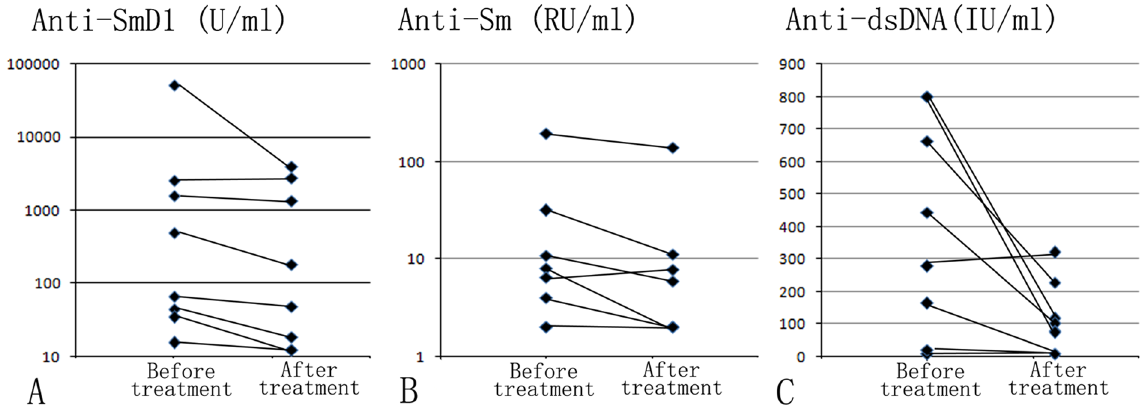
Figure 3. Concentrations of anti-SmD1, anti-Sm and anti-dsDNA in eight naive SLE patients before and after treatment.